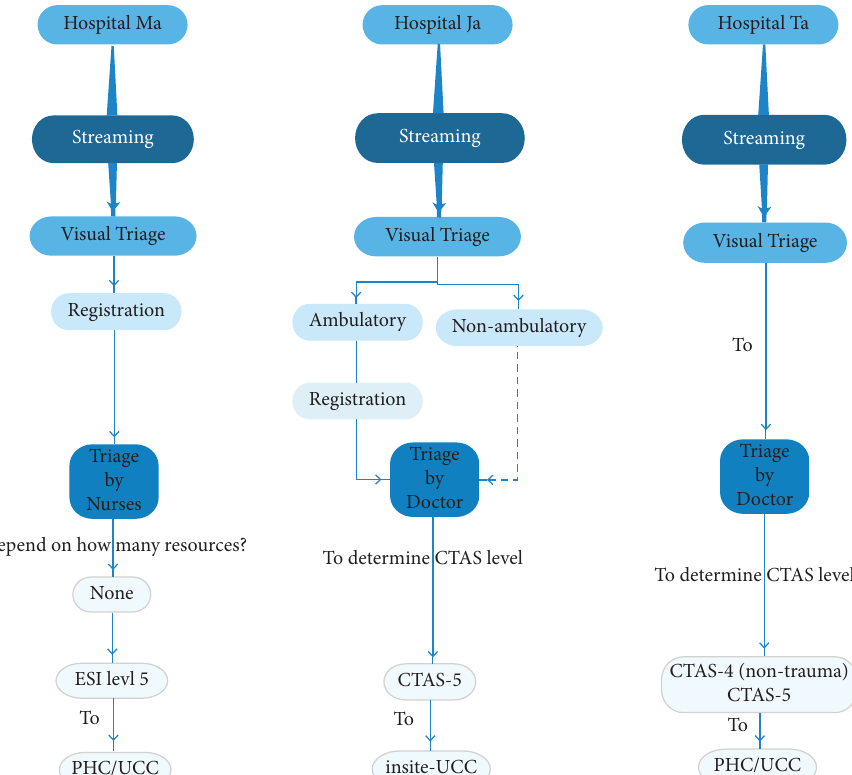
Figure 1: Streaming pathways in the emergency